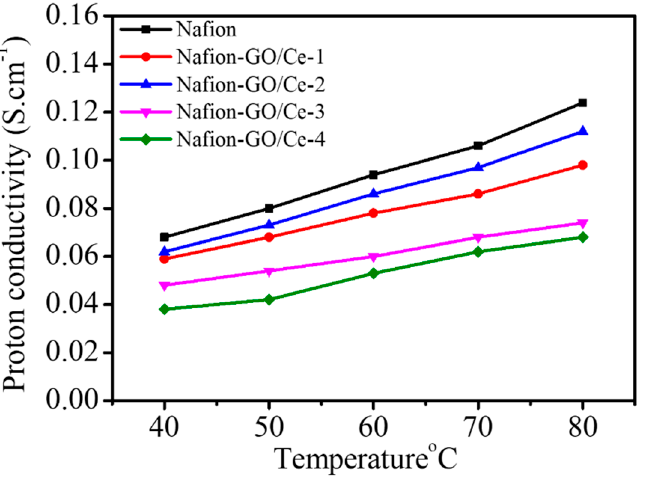
Figure 3. Proton conductivity vs. temperature of different composite membranes.